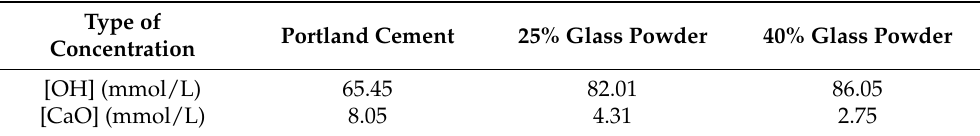
Table 4. The pozzolanic reactivity test